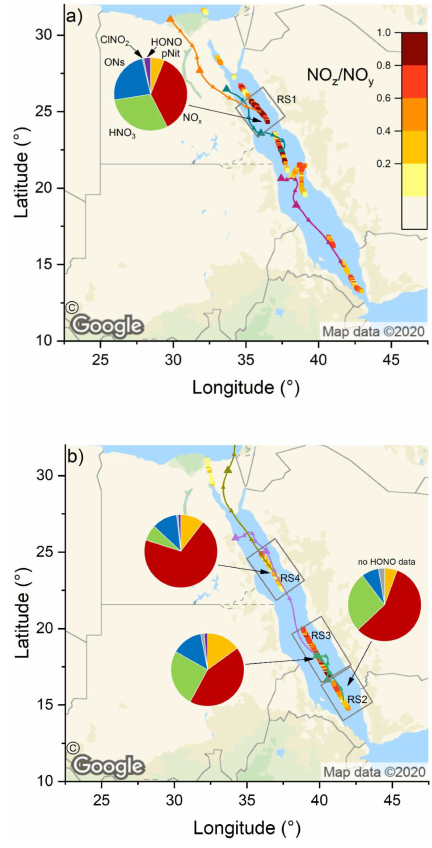
Figure 7. The NO z / NO y ratio over the Red Sea during the (a) first and (b) second leg. Coloured lines are 2d back-trajectories (HYS- PLIT). The pie charts indicate the components of NO y at var- ious segments along the ship’s track (ONs = organic nitrates, pNit = particulate nitrate). HNO 3 was calculated via HNO 3 = NO z – (ONs + pNit + ClNO 2 + HONO). The colours of the pie chart segments are assigned as follows (clockwise): pNit in yellow, NO x in red, HNO 3 in green, ONs in blue, ClNO 2 in grey, and HONO in magenta (© Google